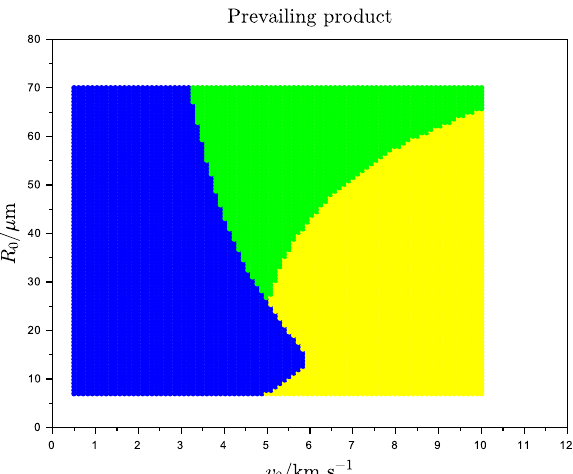
Figure 16. Plot of the prevailing product inside the micrometeorite at the end of its trajectory (blue: retained amino acid, green: aminoketene, yellow: glycine dimer) calculated with L = 1.3 × 10 − 11 m, D 0 = 1.0 × 10 − 12 m 2 s − 1 , and θ 0 = 45.0 deg versus the initial velocity and radius of micrometeoroids with 0.5 ≤ v 0 ≤ 10.0 km s − 1 and 7 ≤ R 0 ≤ 70 µ